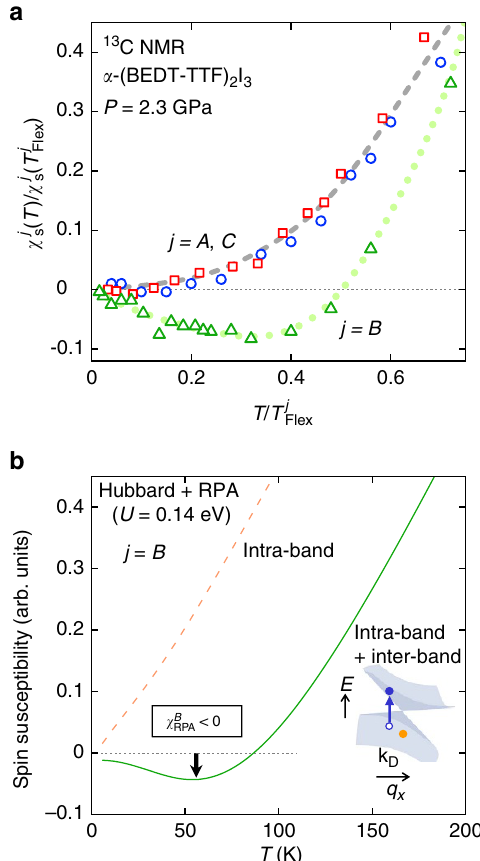
Figure 5 | Emergent negative spin susceptibility at the site B . T ð Þ normalized to the value ( a ) Observed local electron spin susceptibility w j s at the inflection point T j , w j T ð Þ / w j ( T j ), plotted against the normalized s s flex flex , for the non-equivalent site j ¼ A ( A’ ) (circles), temperature, T / T j flex B (triangles) and C (squares) in the unit cell. Dotted and dashed curves are guide to the eyes. ( b ) Calculated T dependence of the B -site-spin susceptibility w B in the RPA based on the Hubbard model. The total s susceptibility (solid curve) and the intra-band contribution (dashed curve) for the onsite Hubbard interaction of U ¼ 0.14eV are shown. Inset: Dirac cone considered for the RPA calculation. The Fermi energy E F locates